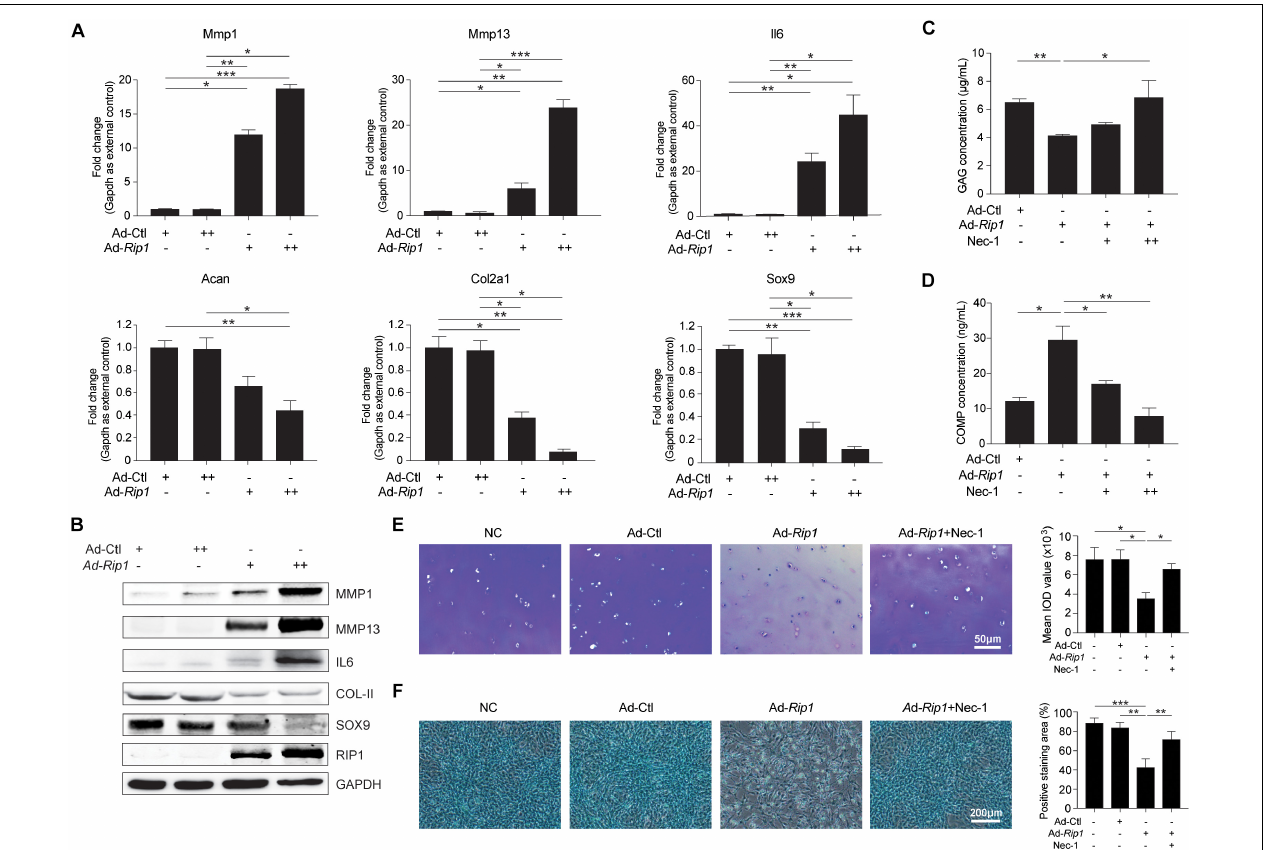
FIGURE 3 | RIP1 promotes catabolism and inhibits anabolism in chondrocytes. (A) The mRNA levels of ECM-related biomarkers Mmp1 , Mmp13 , Il6 , Acan , Col2a1 , and Sox9 in rat chondrocytes treated with Ad-Ctl (100, 200 MOI) or Ad- Rip1 for 24 h ( n = 5 for each group; three independent experiments). (B) The protein levels of MMP1, MMP13, IL6, COL2A1, SOX9, and RIP1 detected by western blotting assay in rat chondrocytes treated with Ad-Ctl (100, 200 MOI) or Ad- Rip1 for 24 h. (C,D) The concentration of GAG in cartilage explants (C) and the concentration of COMP released from the explants (D) treated with Ad-Ctl (100 MOI), Ad- Rip1 or Ad- Rip1 and Nec-1 (50 and 100 µ M) for 10 days ( n = 6 for each group). (E) Toluidine blue staining of the cartilage explants treated with Ad-Ctl (100 MOI), Ad- Rip1 or Ad- Rip1 and Nec-1 (100 µ M) for 10 days ( n = 6 for each group). (F) Alcian blue staining of the chondrocytes treated with Ad-Ctl (100 MOI), Ad- Rip1 or Ad- Rip1 and Nec-1 (100 µ M) for 24 h ( n = 6 for each group). * P < 0.05, ** P < 0.01, and *** P <